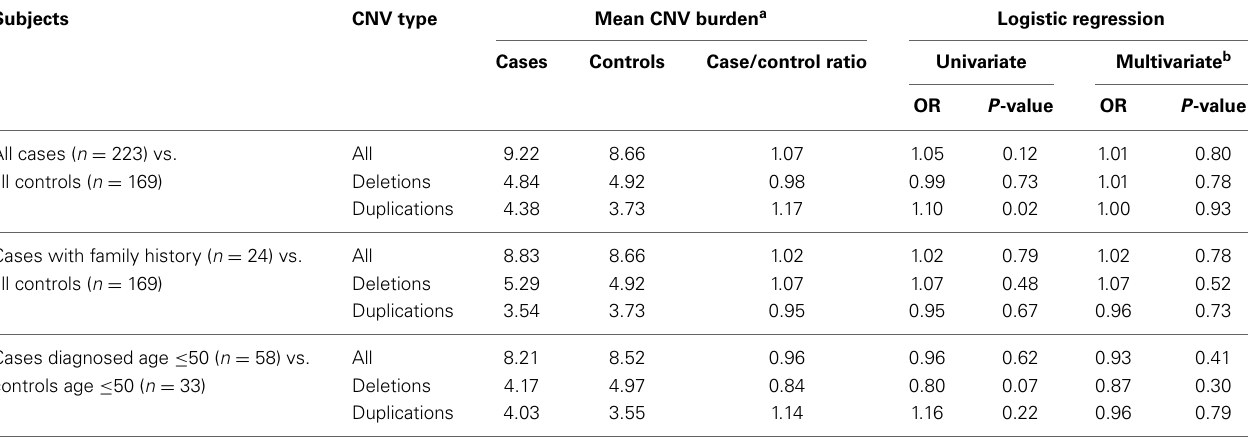
Table 3 | Comparison of global CNV burden in cases and controls based on the final derived set of 3520 QC-filtered CNV calls. Subjects CNV type Mean CNV burden a